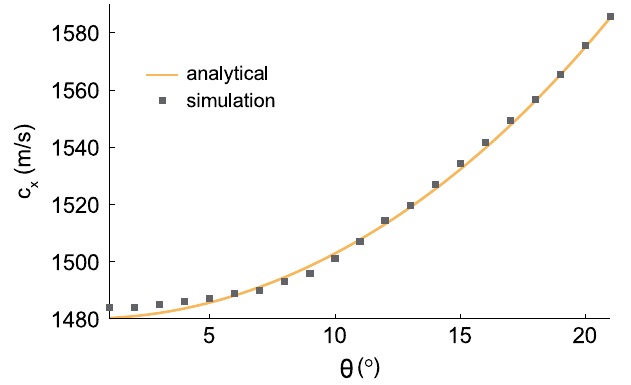
FIG. 9. Analytical and simulated cross-propagating plane-wave intersection velocity as a function of θ